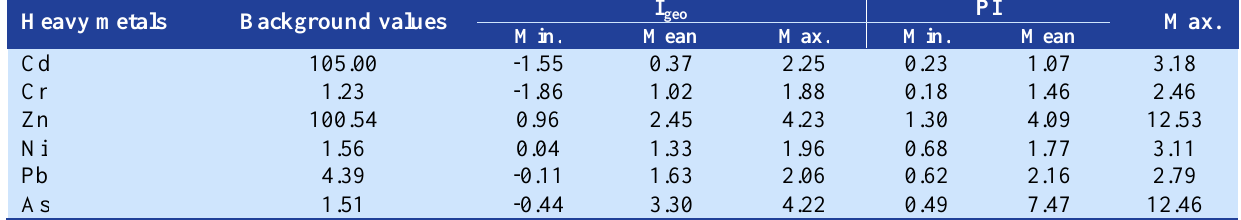
Table 5. Geoaccumulation index (I Heavy